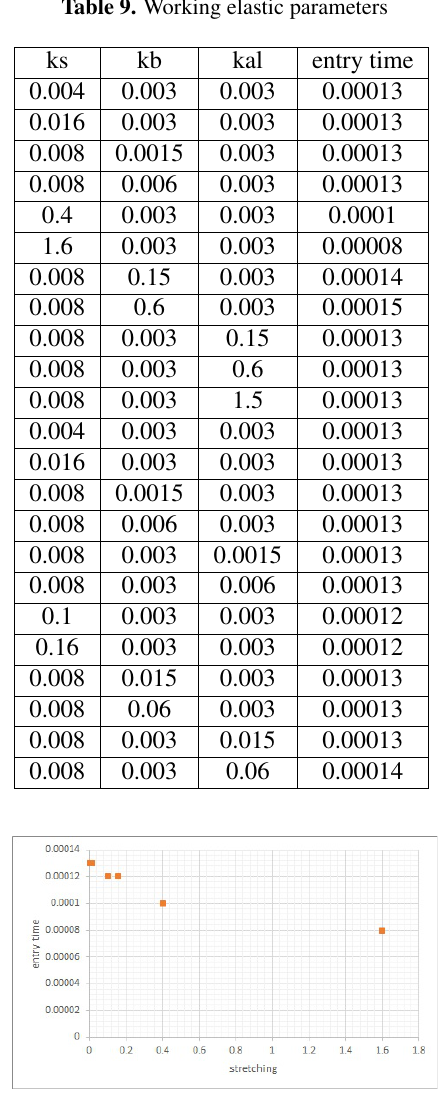
Table 9. Working elastic parameters